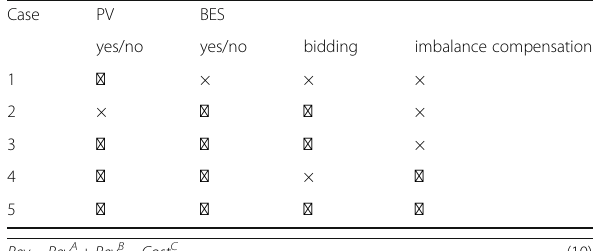
Table 1 (Abstract P12). Study Cases